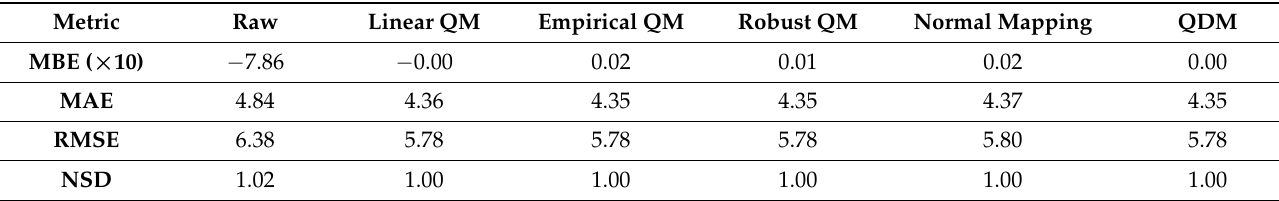
Table 2. Comparison of raw and quantile-mapping (QM) bias-corrected climate model simulations. Mean bias error (MBE), mean absolute error (MAE), root mean square error (RMSE), and normalized standard deviation (NSD) in ◦ C were between model simulations and airport observations during 1993 to 2004 and averaged across climate models. Metric Raw Linear QM Empirical QM Robust QM Normal Mapping QDM MBE ( × 10) −